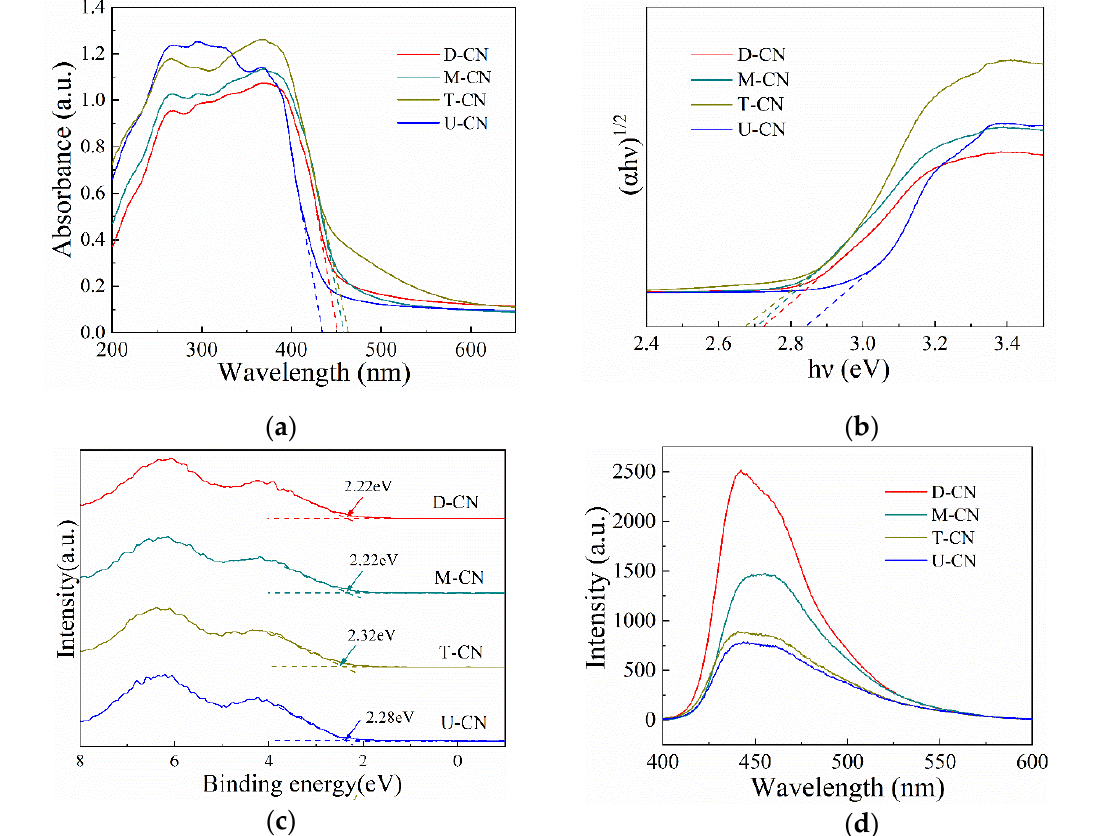
Figure 7. ( a )UV–vis DRS spectra; ( b )Tauc plots for estimating the bandgap (Eg) values ( c ) XPS valance band (VB) spectra and ( d ) band structure of D － CN, M － CN, T － CN and U － CN.